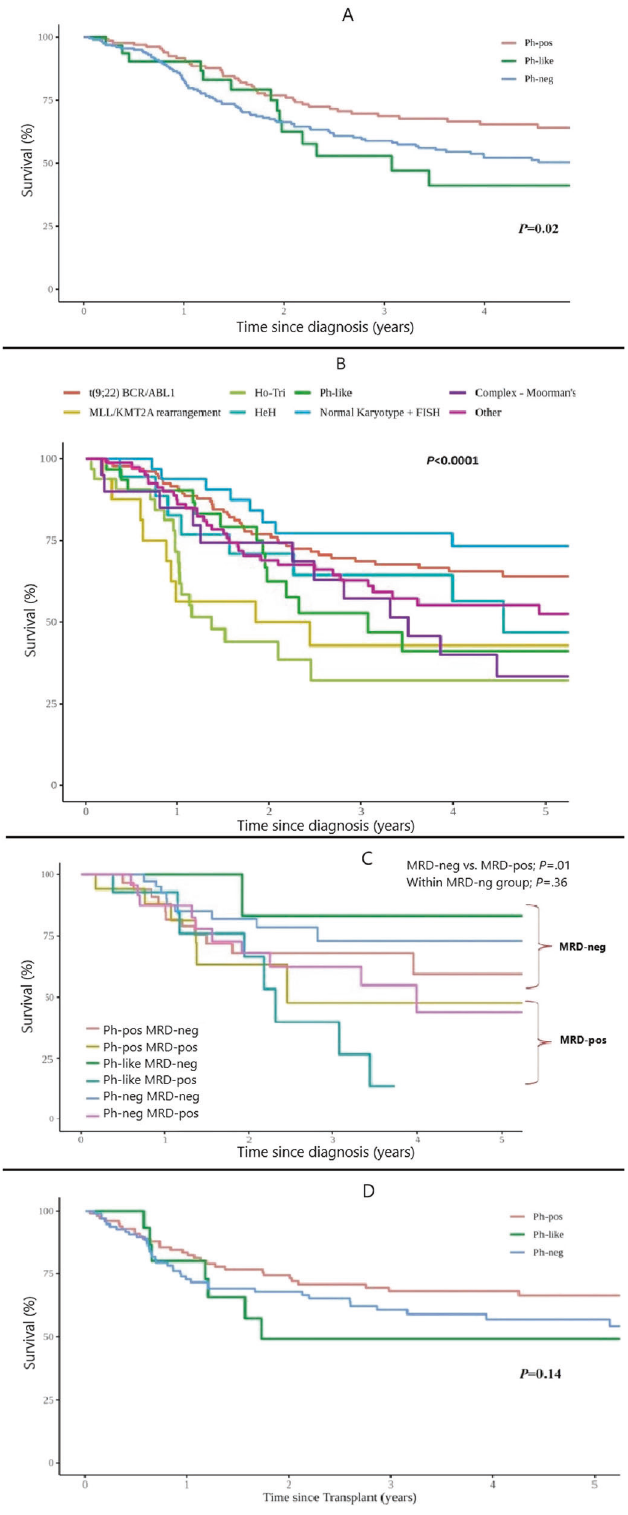
Fig. 1 Outcomes of patients with Ph-like ALL in comparison to other groups. A Overall survival of Ph-like, Ph-pos, and Ph-neg ALL. B Overall survival by cytogenetic subgroup. C Overall survival by MRD status. D Overall survival after